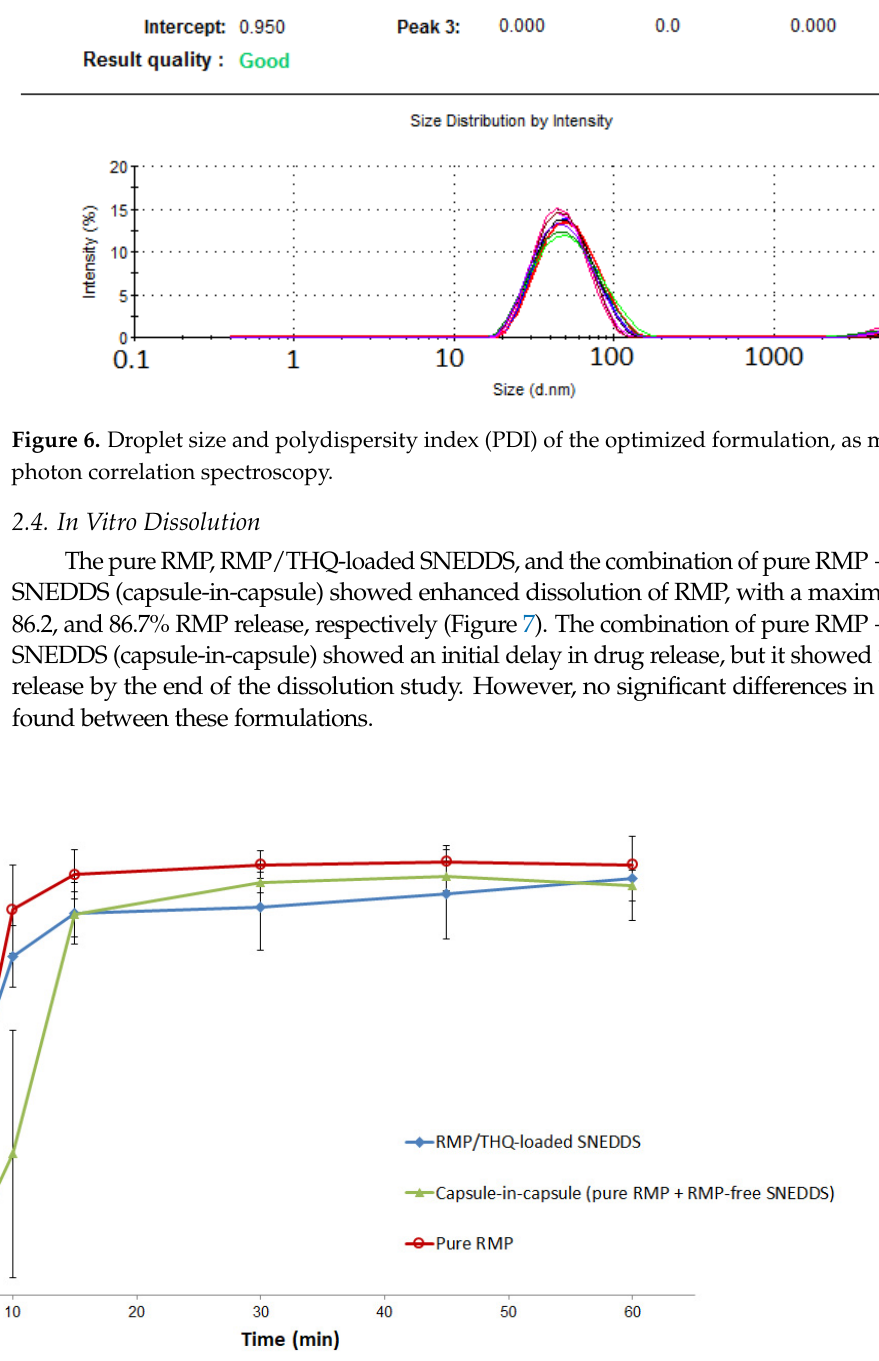
Figure 7. In vitro dissolution of RMP SNEDDS formulations at pH 1.2. Data are represented as the mean ± SD, n = 3.